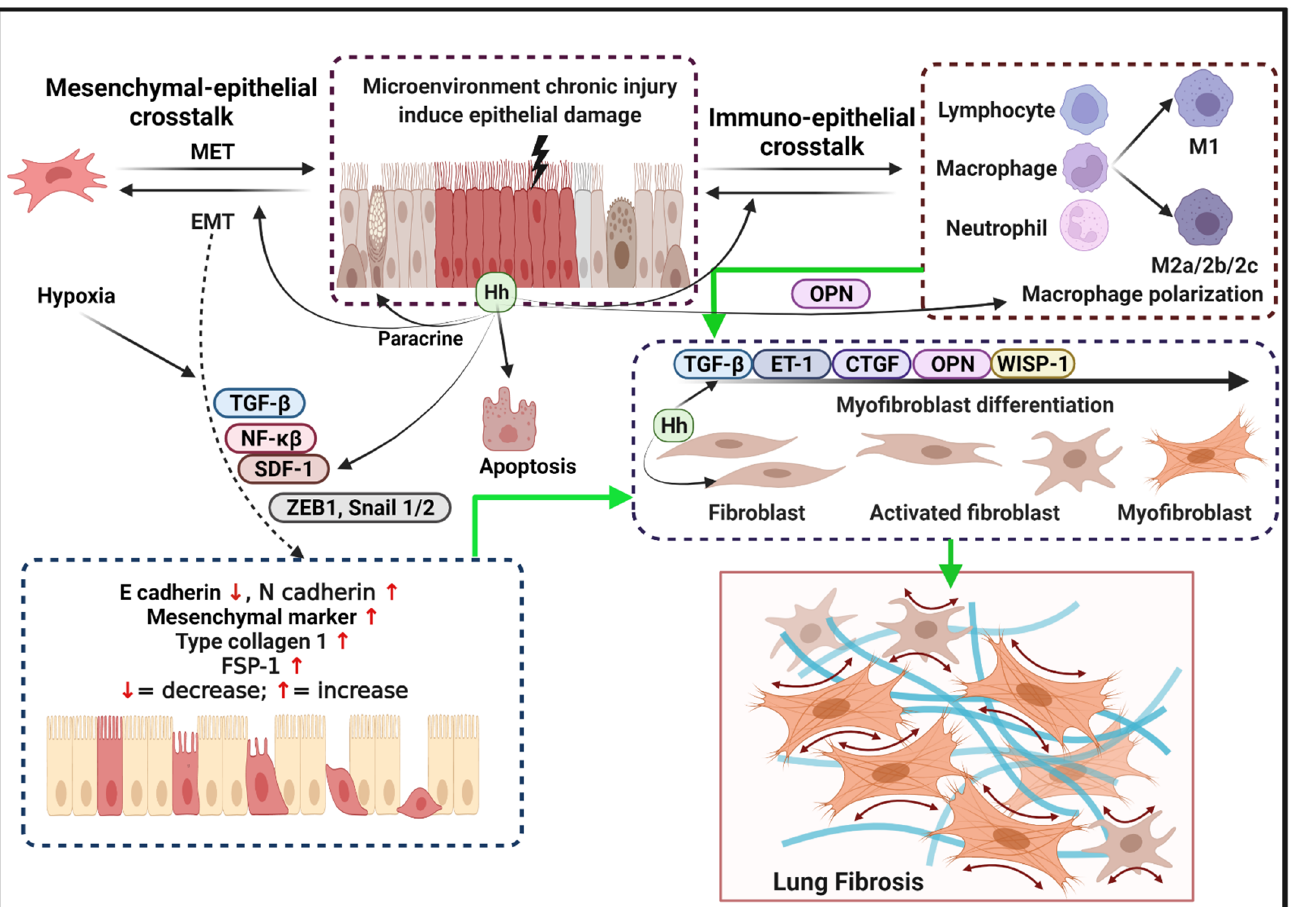
Figure 2. Model of uncontrolled reactivation of Hh signaling in the pathogenesis of IPF .